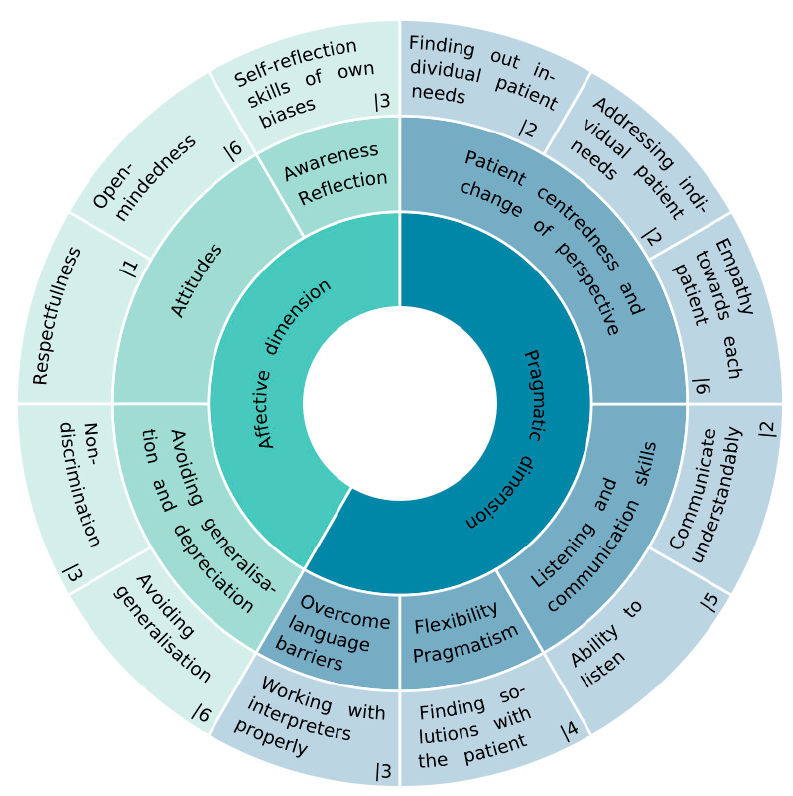
Figure 1. Highest-ranked diversity competences (rank number, see outer ring) according to mean value grouped by thematic categories and diversity dimensions.